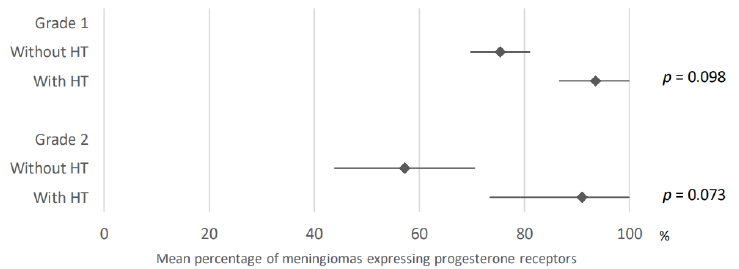
Figure 8. Comparison of progesterone receptors expression in meningiomas developed under and without hormonal treatment according to grade. HT: hormonal treatment. The results are expressed